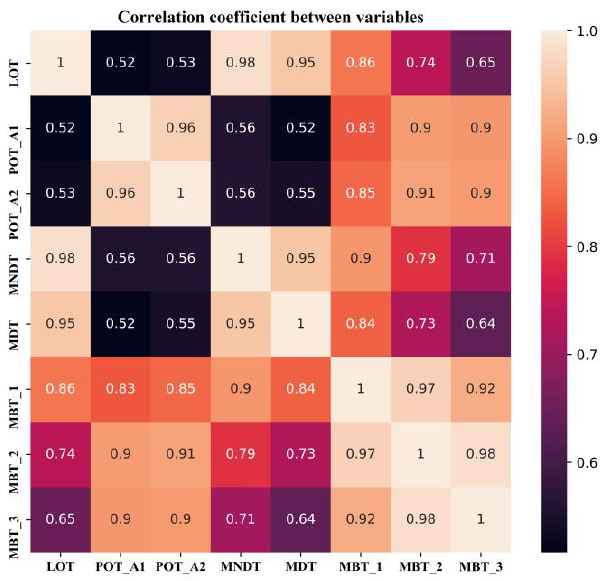
Figure 5. The correlation coefficient between variables.